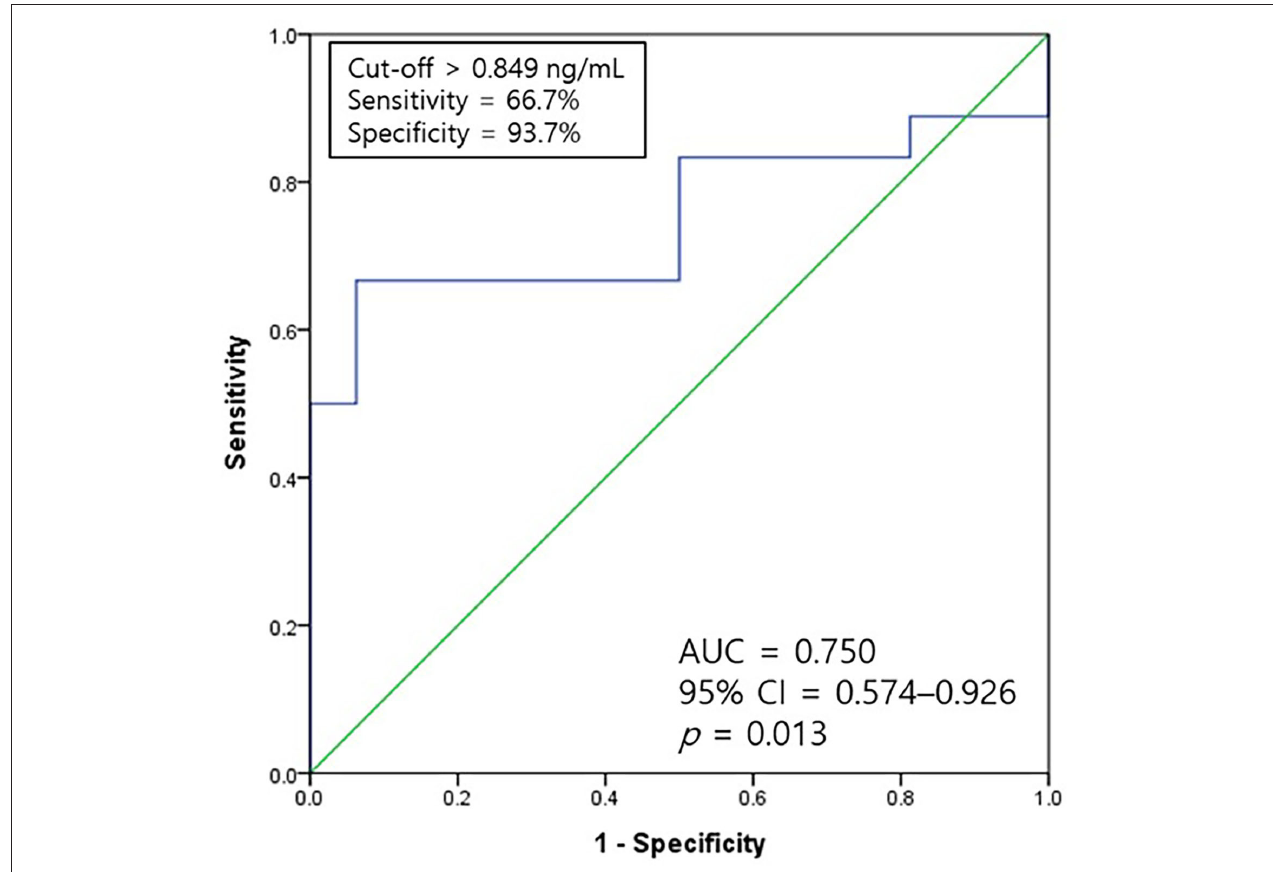
FIGURE 3 | A ROC curve of galectin-3 for predicting the occurrence of diastolic dysfunction. The AUC value of galectin-3 was 0.750 with a sensitivity of 66.7% and specificity of 93.7% at a cutoff level of 0.849ng/ml ( p = 0.013). AUC, the area under the curve; CI, confidence interval; ROC, receiver-operating characteristic.